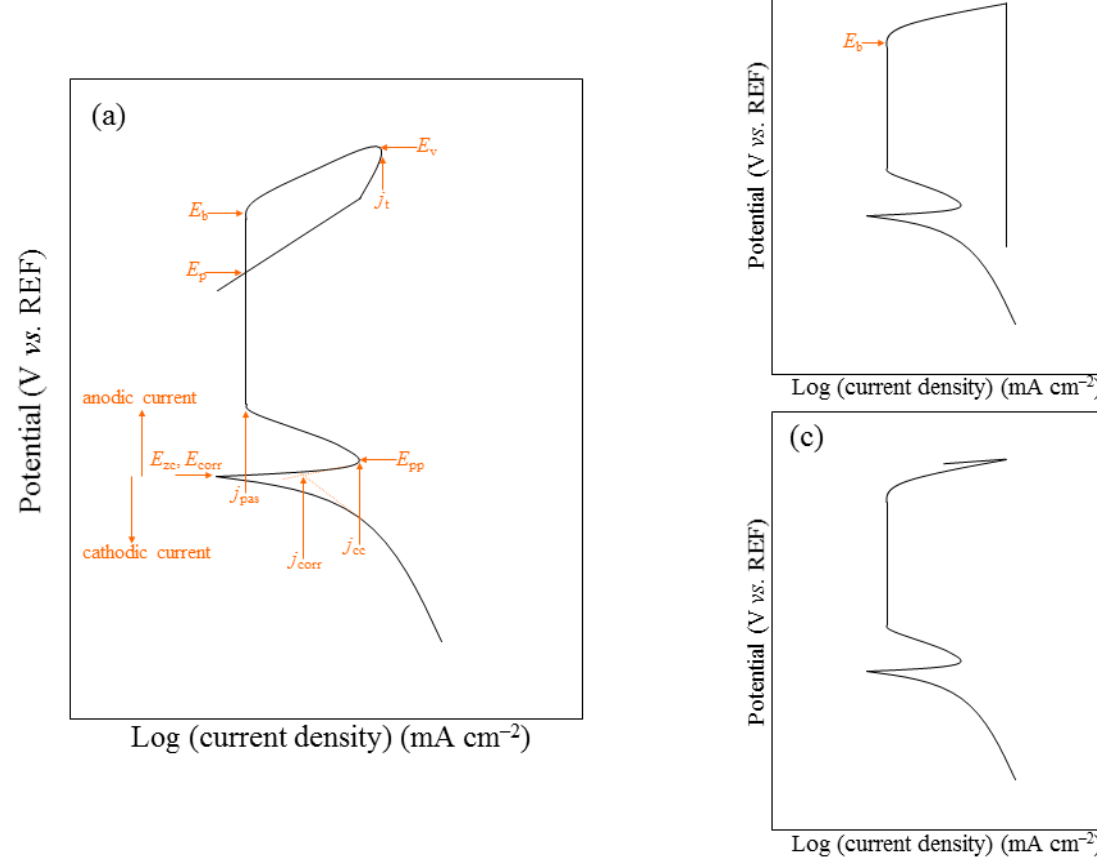
Figure 6. Schematics of cyclic potentiodynamic polarization curves of: ( a ) a metal that exhibits a protection potential, ( b ) a metal that does not exhibit a protection potential and ( c ) a metal that repassivates.